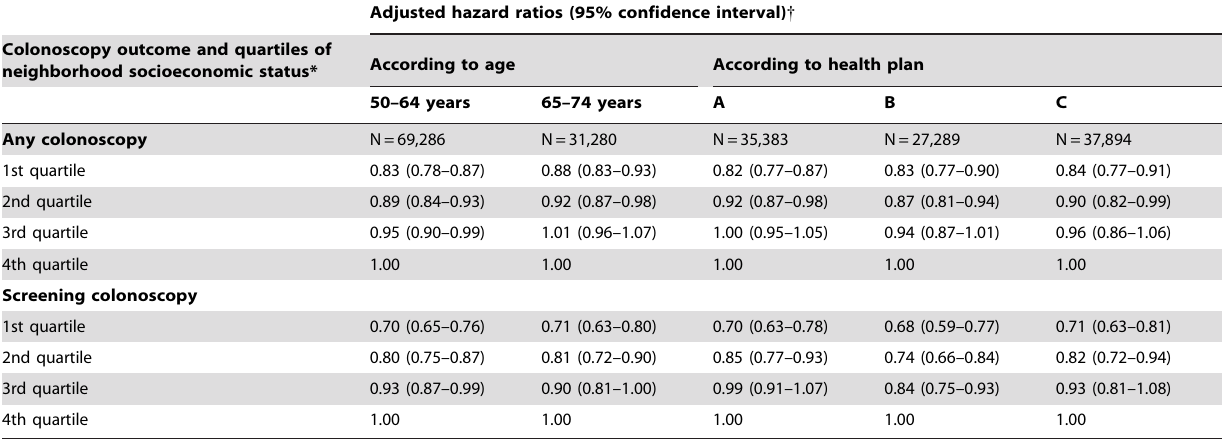
Table 4. Association between neighborhood socioeconomic status and use of colonoscopy according to age and health plan,